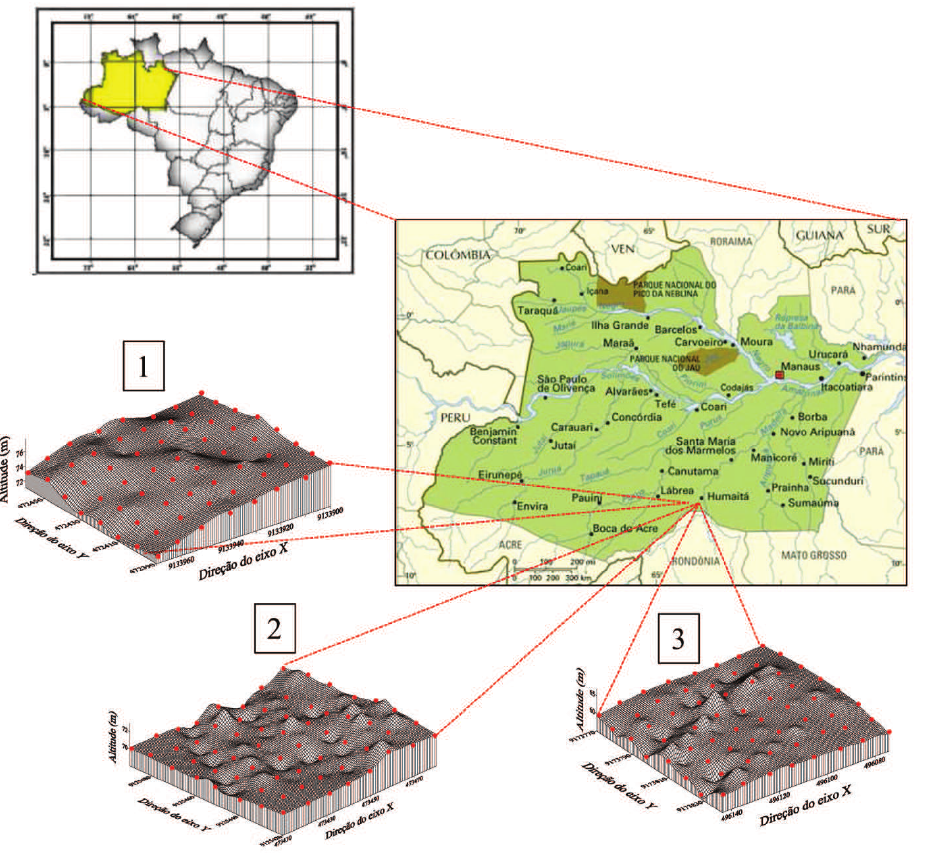
Figura 1. Localização e modelo de elevação digital: 1 = área com mandioca; 2 = área com cana-de-açúcar; e 3 = área com agrofloresta, na região sul do